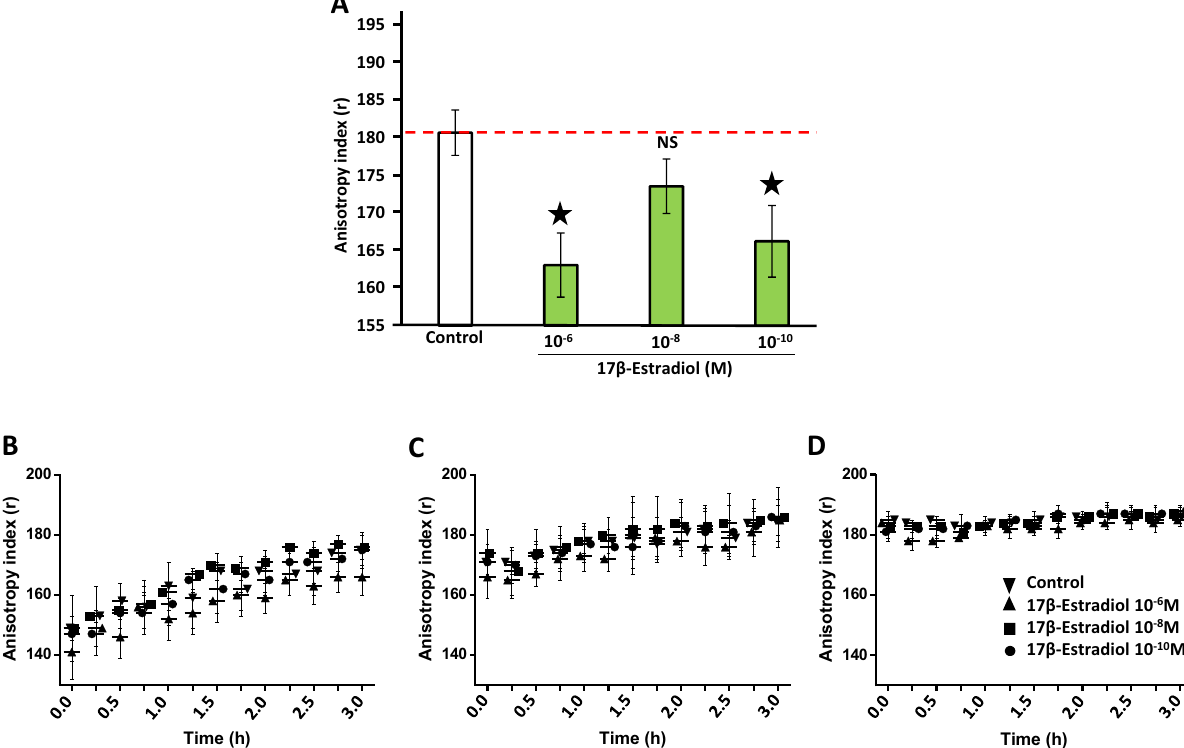
Figure 1. Effect of 17β-estradiol on Lactobacillus crispatus CIP104459 membrane fluidity. ( A ) Membrane fluidity (anisotropy index) of L. crispatus CIP104459 grown for 18 h in the absence (control) or presence of 17β-estradiol (10 –6 , 10 –8 and 10 –10 M). ( B ) Membrane fluidity (anisotropy index) of L. crispatus grown for 6 h in control MRS medium and then exposed to 17β-estradiol (10 –6 , 10 –8 or 10 –10 M). ( C ) Membrane fluidity (anisotropy index) of L. crispatus grown for 12 h in control MRS and subsequently exposed to 17β-estradiol (10 –6 , 10 –8 or 10 –10 M). ( D ) Membrane fluidity (anisotropy index) of L. crispatus grown for 24 h in control MRS medium and subsequently exposed to 17β-estradiol (10 –6 , 10 –8 and 10 –10 M). Values and curves are the means ± SEM of three independent studies. (NS: not significant; * = p < 17β‑Estradiol alters the morphology of L. crispatus CIP104459, but not its aggregation phe - notype. As membrane fluidity can affect cell morphology or aggregation, we then investigated the effects of 17β-estradiol on these phenotypes in L. crispatus CIP104459. For macroscopic investigations of the aggregation phenotype, we first performed a “sedimentation” technique, as previously described by Vandevoorde et al. 38 . 17β-estradiol had no effect on the aggregation potential of L. crispatus CIP104459 in these conditions. The percentage aggregation reached a mean value of 66.6 ± 1.6% in control bacteria and of 65.3 ± 2.2, 62.9 ± 1.3, and 66.4 ± 1.2% in bacteria cultured in the presence of 10 –6 , 10 –8 and 10 –10 M 17β-estradiol, respectively (Suppl. Fig. 2). The effect of 17β-estradiol on L. crispatus CIP104459 was assessed further by flow cytometry, which can provide information about cell aggregation, mean size, and structural heterogeneity (granularity). This infor- mation is obtained by determining the forward scatter (FSC) and lateral or side scatter (SSC) fractions of the light 39 . We plotted the FSC and SSC values of L. crispatus CIP104459. For FSC ( x axis), the maximal size of the detected events (in red) was decreased by exposure to 17β-estradiol, whereas the signal corresponding to small events (in blue) increased (Fig. 3A). This pattern was particularly marked for bacteria exposed to 10 –6 and 10 –8 M 17β-estradiol, and was less clear for those exposed to 10 –10 M of 17β-estradiol, although small particles continued to predominate, relative to control conditions. By contrast, the surface heterogeneity (granularity) of the bacteria, corresponding to the SCC values ( y axis), was not modified. The difference in FSC values between control and 17β-estradiol-treated bacteria was not significant, probably because this signal combines two differ- ent types of information, relating to the degree of aggregation of the bacteria and their mean size. Overall, these data suggest that 17β-estradiol affects the morphology of L. crispatus CIP104459. Scanning electron microscopy (SEM) observations of cells revealed that 17β-estradiol had no detectable effect on aggregate formation (Fig. 3B). Measurements of cells’ length on SEM images led to L. crispatus CIP104459 cells being classified as small (1 to 2 µm) to large (4 to 9 µm). Remarkably, treatment with 10 –8 or 10 –10 M 17β-estradiol led to significant increases in the proportion of small bacteria ( p < 0.001) and decreases in the portion of large bacteria ( p < 0.01) (Fig. 3C). 17β‑Estradiol promotes biosurfactant production by L. crispatus CIP104459. Biosurfactants are surface-active molecules that can reduce air/water surface tension to low levels. Some of these molecules can insert into bacterial membranes and modify membrane fluidity 40 . Cultures of L. crispatus CIP104459 exposed